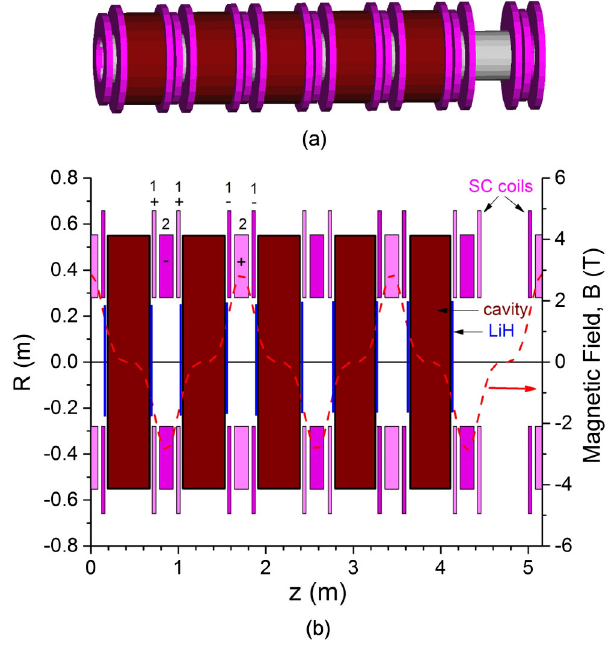
FIG. 3. Schematic representation of the LBC lattice: (a) Con- figuration in 3D; (b) side view. Note that six cells are shown. The magenta cylinders are solenoids, the red cylinders are the active volume of the rf cavities, and the blue blocks are LiH absorbers. The dashed red line shows the magnetic field distribution along the axis. The current densities for coils 1 and 2 are 200 and 167 A = mm 2 , respectively.